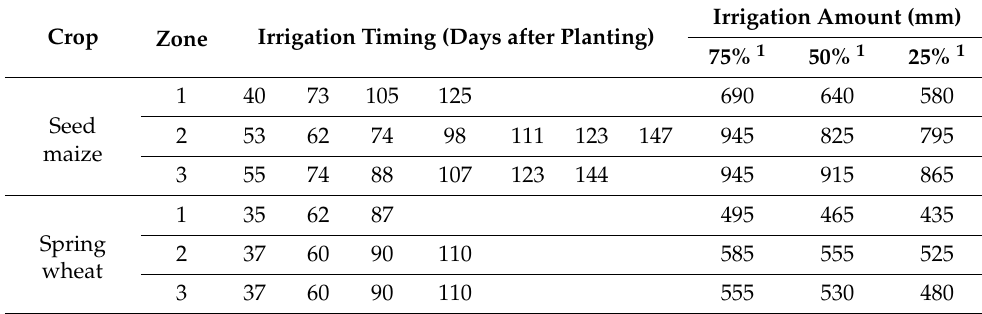
Table 1. Generalized current irrigation schedule.